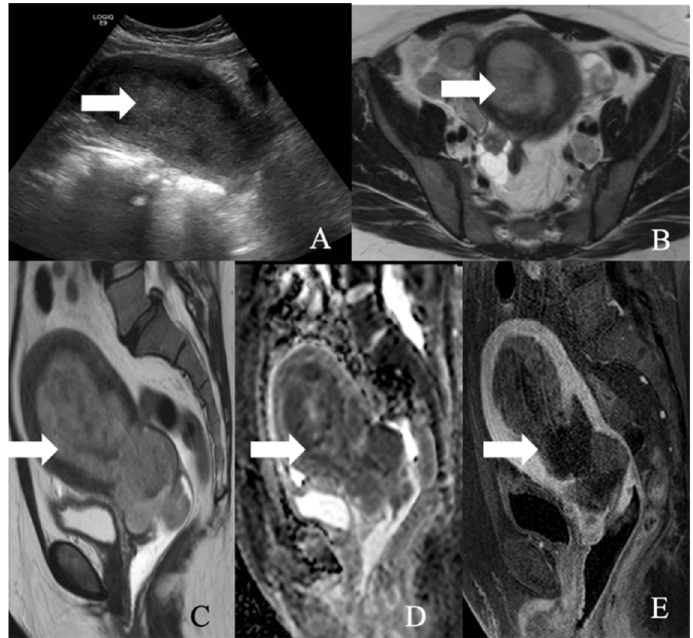
Figure 11. A 52-year-old female with a large cell neuroendocrine tumor of the endometrium. ( A ) Transverse ultrasound image of the uterus demonstrates thickened endometrium (arrow), ( B ) axial T2 weighted image, ( C ) sagittal T2 weighted image, ( D ) sagittal apparent diffusion coefficient map, and ( E ) sagittal fat-saturated post-contrast T1 weighted MRI images demonstrate a hypoenhancing tumor in the endometrium (arrow) with restricted diffusion.